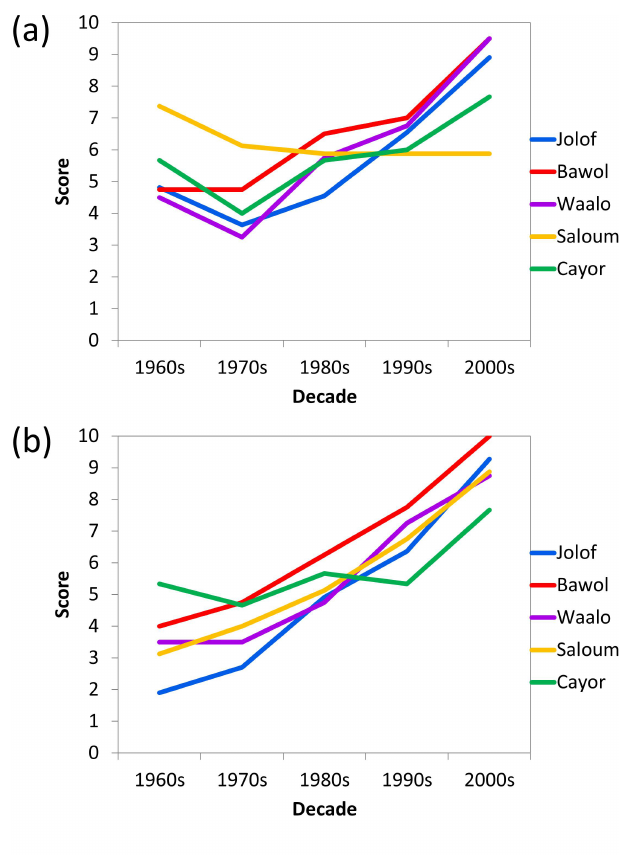
Fig. 8. Perceptions (average matrix scores) of the evolution of cattle (a) and small ruminant (b) populations from the 1960s to the 2000s, averaged by